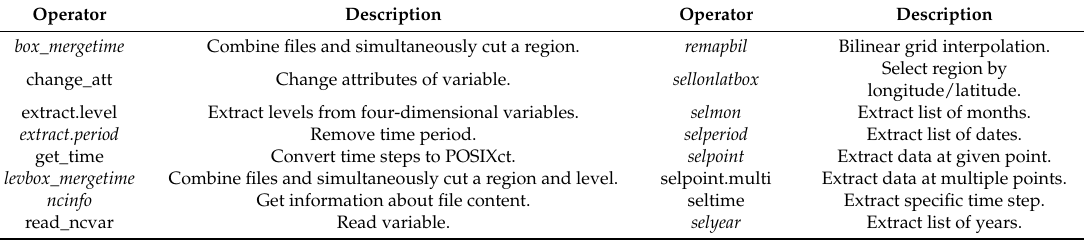
Table 2. Operators for data manipulation of the cmsaf R-package (version 1.9.5). Operators that are included in the CM SAF R Toolbox are marked in